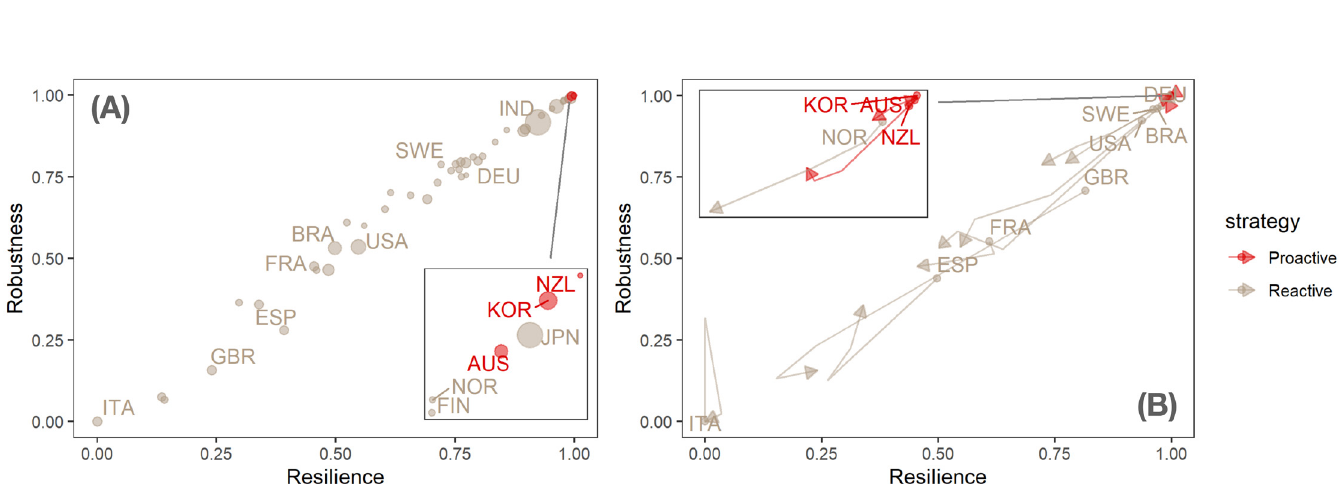
Fig 5. Proactive vs reactive strategies to COVID-19 pandemic. (A) static shock map where each point indicates a country and colors code proactive vs reactive response strategies. Remarkably, proactive strategies have a clear advantage, although some countries with reactive strategies, such as Nordic ones (except for Sweden) and Japan, perform similarly in robustness and resilience. (B) For a subset of countries, the evolution of their shock response over time is shown at different temporal snapshots.